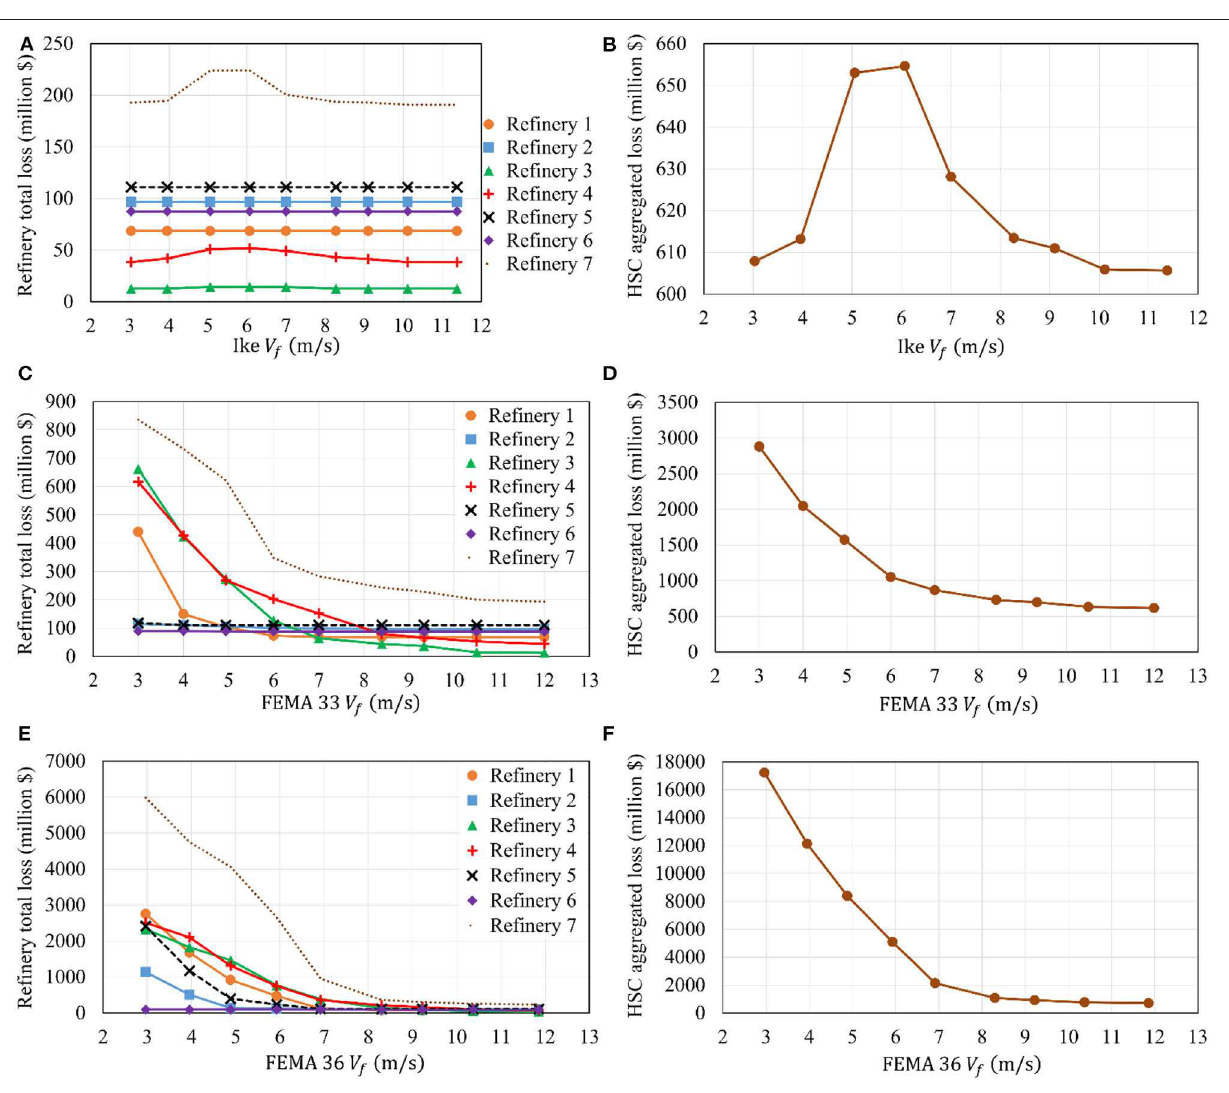
Frontiers in Built Environment | www.frontiersin.org